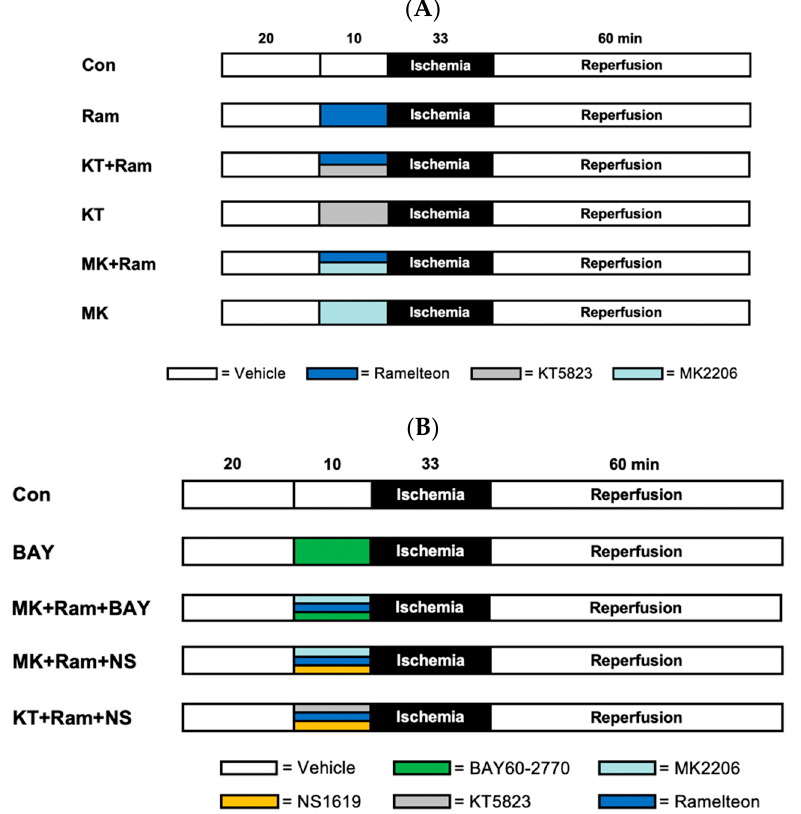
Figure 3. Experimental protocol Part 1 ( A ) and Part 2 ( B ). ( A ) Con = Control, Ram = Ramelteon, KT